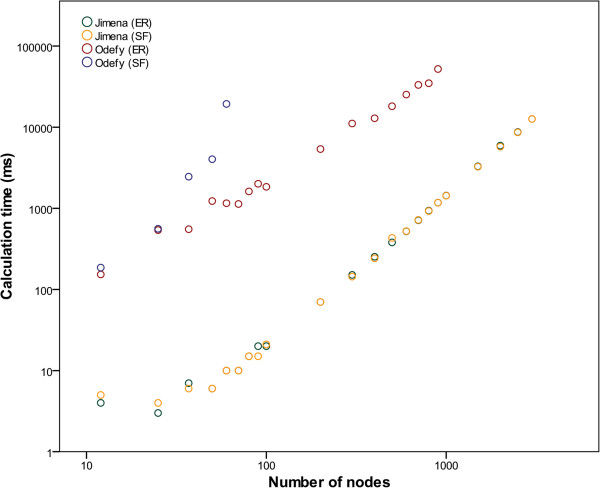
BooleCube network performance of Jimena and Odefy. Random Erdős–Rényi and scale-free networks with a given number of nodes n and 3·n interactions (arrows) were simulated for 10 seconds with a step size of 0.05 s in Jimena. The scale-free networks were grown using a preferential attachment mechanism. All simulations were aborted after a maximum of 1 minute calculation time.